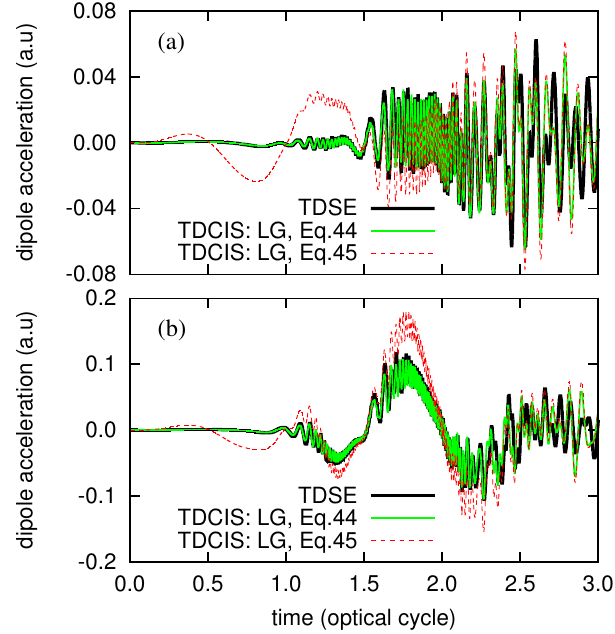
Figure 2. Time evolution of the dipole acceleration of 1D-He exposed to a laser pulse with a wavelength of 750 nm and an intensity of ( a ) 5 × 10 14 W/cm 2 and ( b ) 1 × 10 15 W/cm 2 . Comparison of the results with TDCIS in the LG adopting Equations (44) and (45) with that of